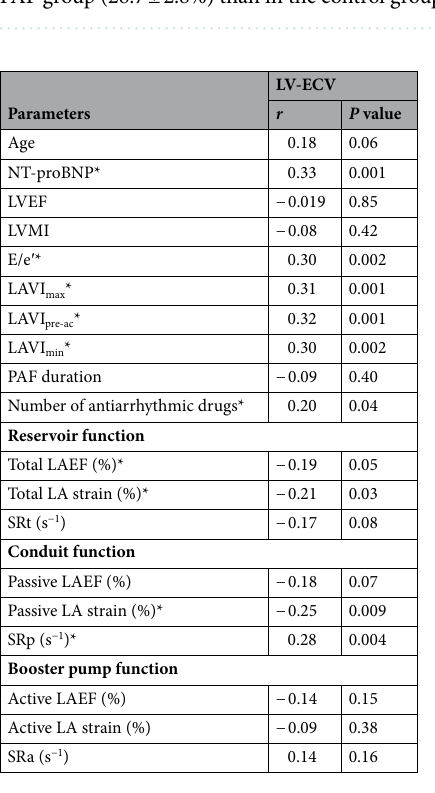
Table 4. Correlation of LV-ECV in PAF patients. ECV extracellular volume fraction, LAEF left atrial empty fraction, LAVI left atrial volume index, LV left ventricular, LVEF left ventricular ejection fraction, LVMI left ventricular mass index, NT-proBNP N terminal pro B type natriuretic peptide, PAF paroxysmal atrial fibrillation, SR strain rate. *P <